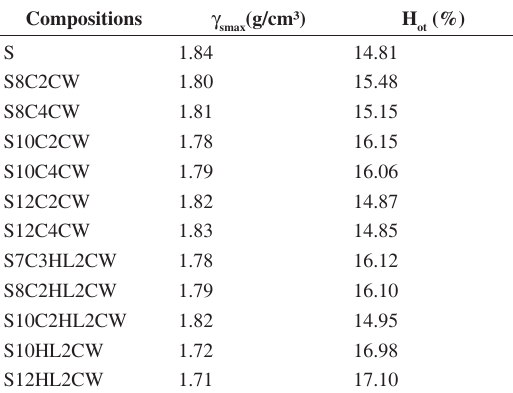
Table 3. Maximum dry apparent specific weight and H cement and CW compositions.